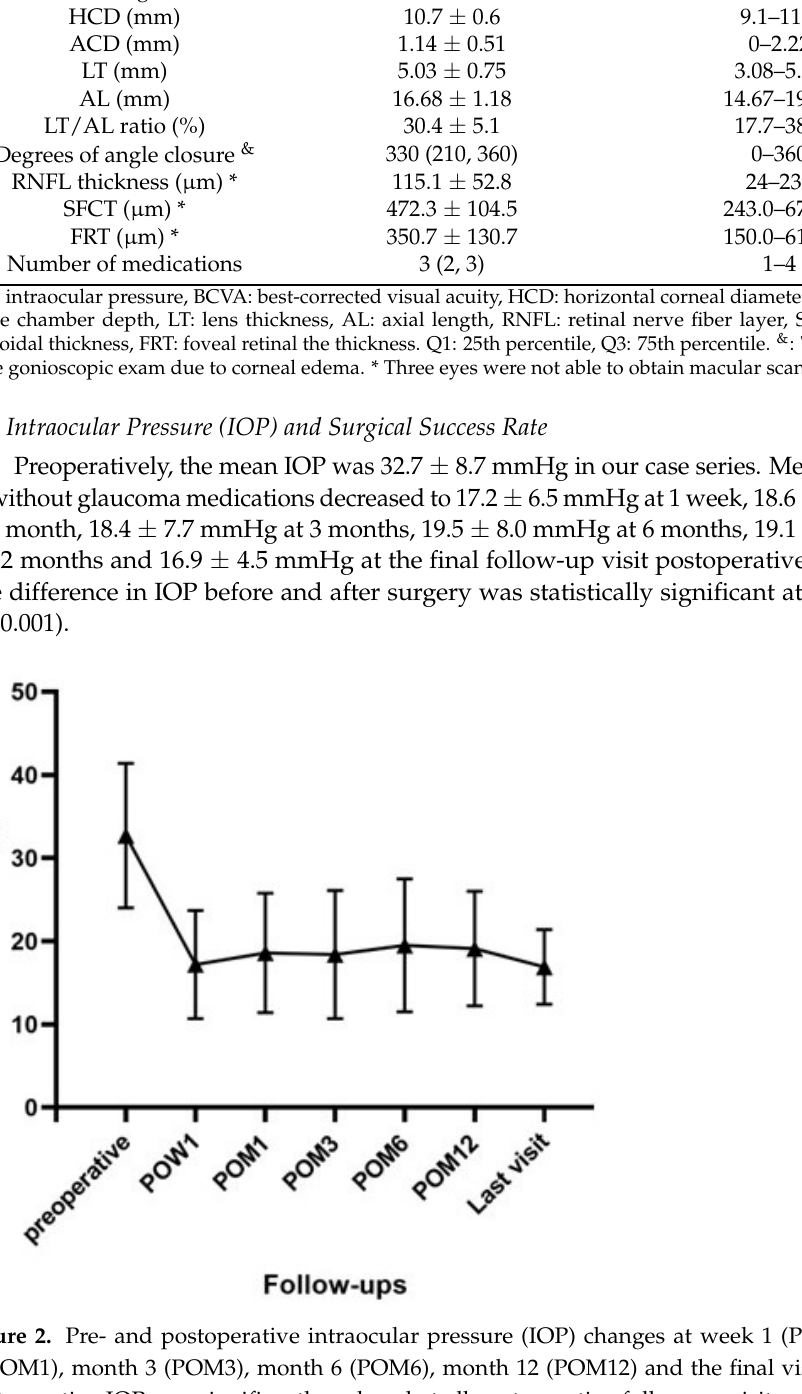
Figure 2. Pre- and postoperative intraocular pressure (IOP) changes at week 1 (POW1), month 1 (POM1), month 3 (POM3), month 6 (POM6), month 12 (POM12) and the final visit. The mean